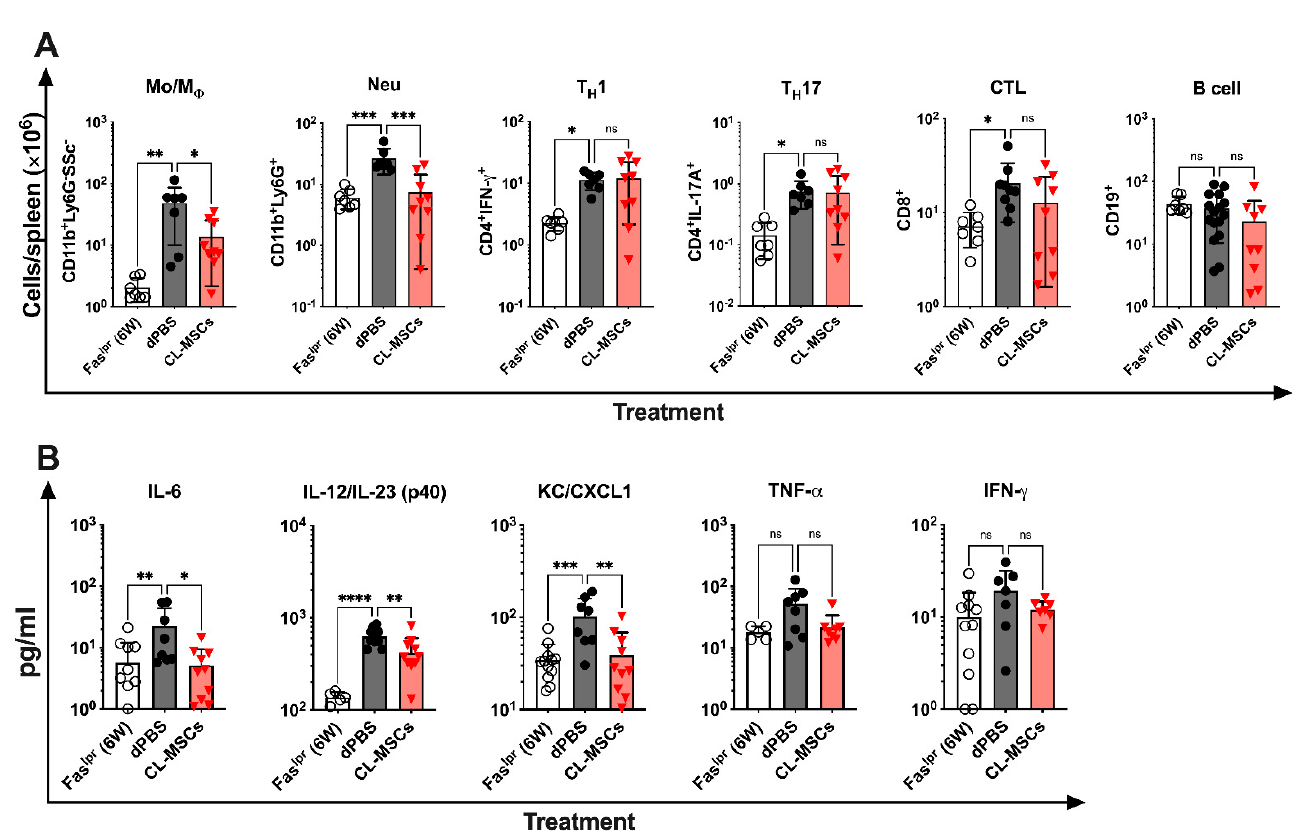
Figure 4. CL-MSCs mediated immunomodulation through targeting monocytes/macrophages and neutrophils and their pro-inflammatory cytokines: ( A ) The immune profile was analyzed on mouse spleen cells by flow cytometric analysis in six-week-old pre-onset Fas lpr mice (n = 7) and at three weeks PT treated with dPBS (n = 7) and CL-MSCs (n = 9). ( B ) Cytokine profile of plasma samples was performed in six-week-old Fas lpr mice (n = 9) and at three weeks PT treated with dPBS (n = 8) and CL-MSCs (n = 10) by Luminex assay. The results are expressed as the mean ± SD. For multiple comparisons, the significance was defined as * p < 0.025; ** p < 0.005; *** p < 0.0005; **** p < 0.00005 when n = 2. One-way ANOVA Dunnett’s test was used for multiple comparison with 95% confidence interval.